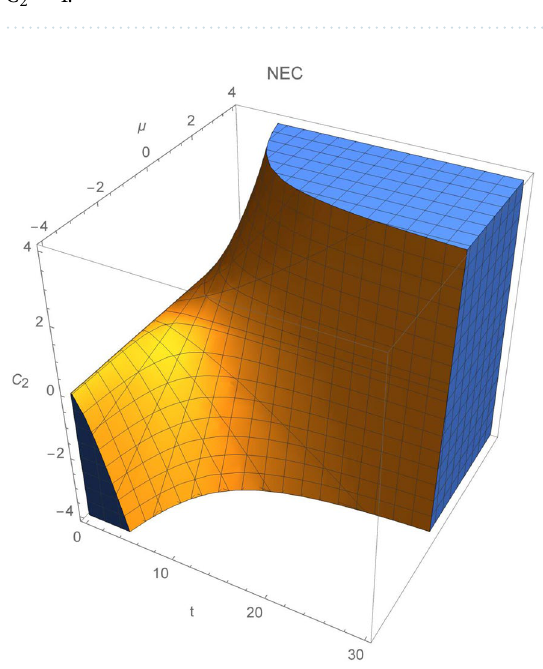
P eff is plotted for +